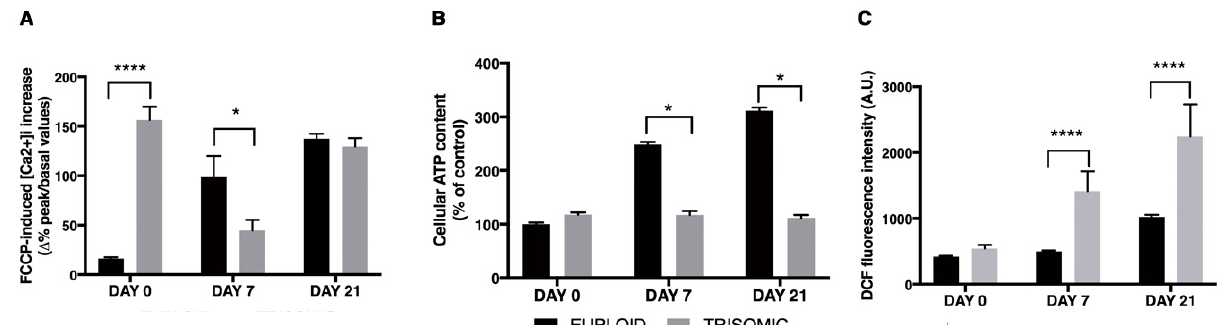
Figure 11. Analysis of mitochondrial function in euploid and trisomic iPSCs and NPCs at day 7 and 21 of culture in dif- ferentiation medium. ( A ) The level of [Ca 2+ ] i was measured with Fura-2AM after FCCP treatment. The bars show the mean values ± SEM of determinations, as percentage difference of peak values (after FCCP) with respect to basal [Ca 2+ ] i , from at least 25 cells/condition. ( B ) Cellular ATP content, measured by an ATP bioluminescent assay, was expressed as percentage of Eu-iPSC values (set equal to 100). The bars show the mean values ± SEM of determinations from three independent experiments. ATP levels were normalized to protein content of each sample. ( C ) ROS production was measured by DCF fluorescence intensity. The bars show the mean values ± SEM of determinations, in arbitrary units, from at least 25 cells/condition. Values of trisomic cells represent the average of the two trisomic clones used. * p < 0.05; **** p < 0.0001.